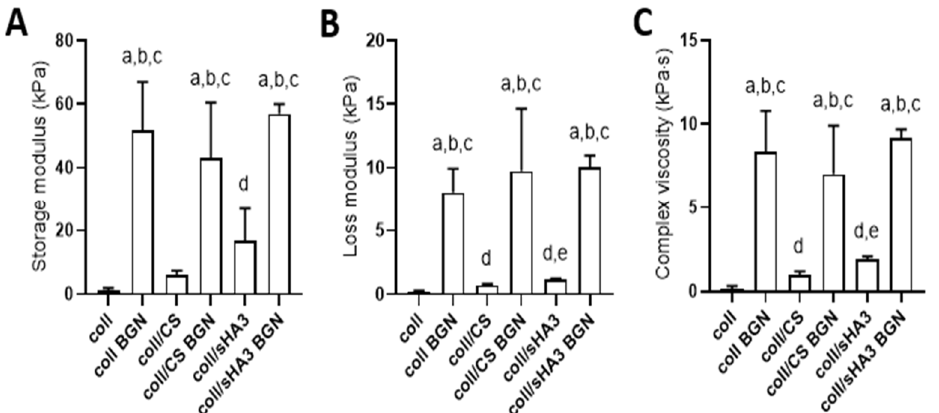
Figure 4. Viscoelastic characteristics of aECM coatings: Rheological measurements were performed at 1 Hz. Storage modulus ( A ), loss modulus ( B ), complex viscosity ( C ). Statistic: p < 0.05 was considered significant. One-way ANOVA over all data with significant differences to coll (a), coll/CS (b), or coll/sHA3 (c). One-way ANOVA for data without BGN with significant difference to coll (d) and coll/CS (e).